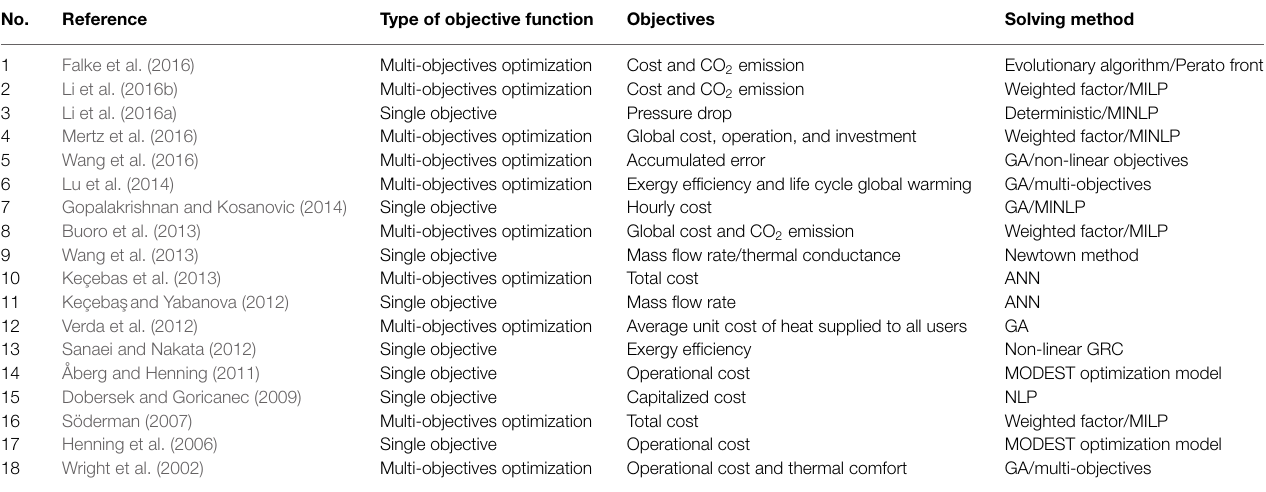
TABLE 4 | Summary of the recent DHS optimization studies